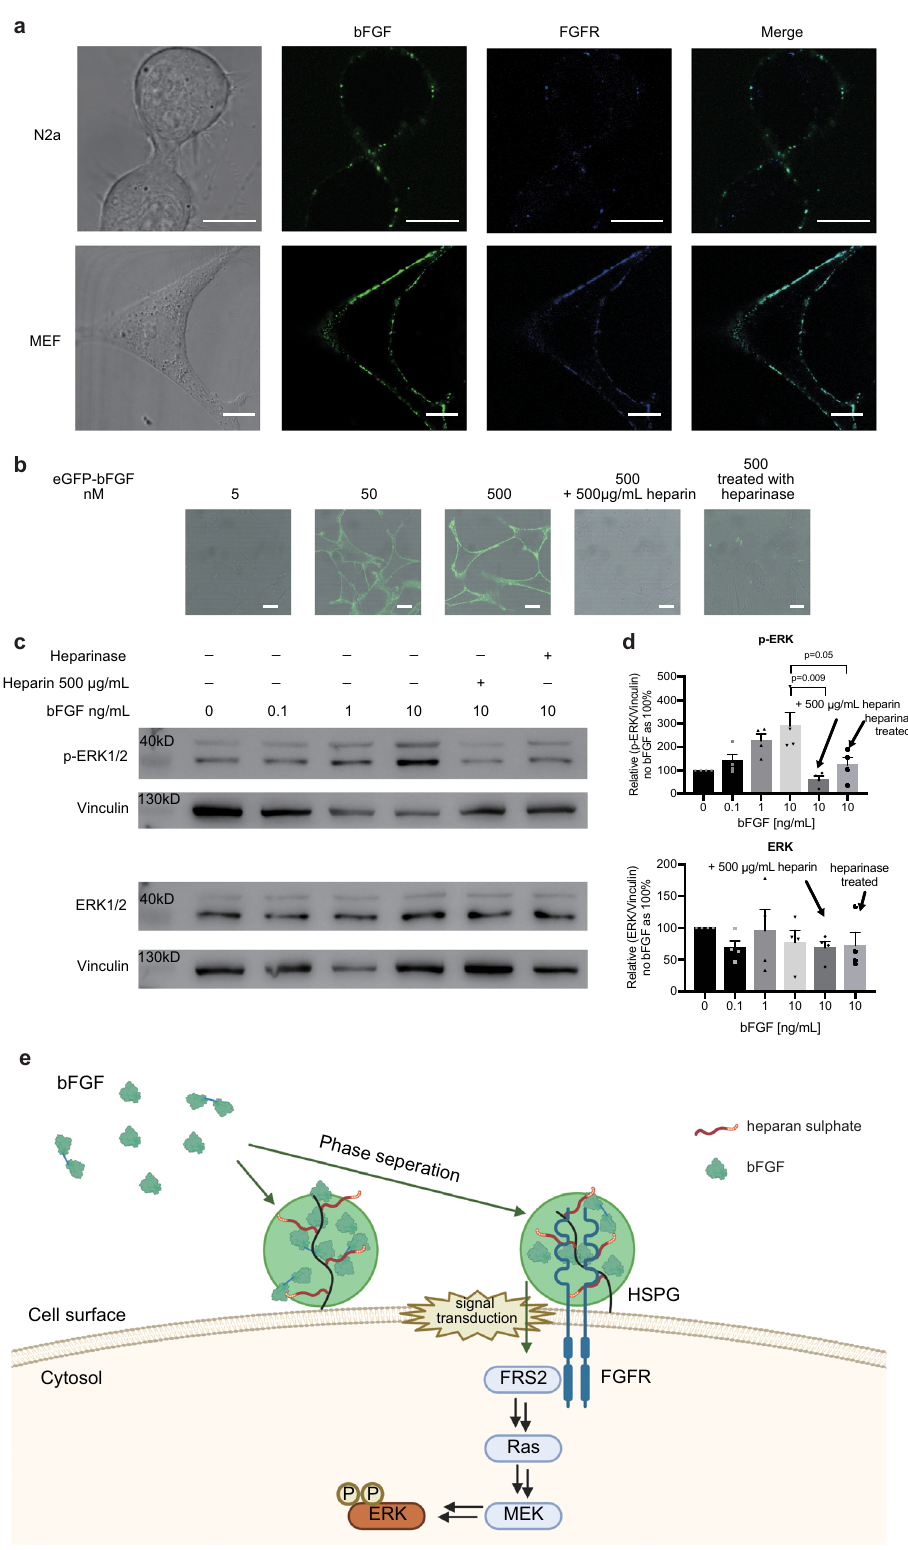
Turbidity assay . Proteins were prepared as described above. The protein solution was mixed with various concentrations of heparin (0~5µM) and PEG-8000 (0 – 20% w/v) in the assay. All operations were performed on ice. The mixed protein solution was immediately loaded into a 384-well plate and incubated for 5 – 7h at 4°C before measuring. Turbidity was measured by absorption at 277 nm in 384-